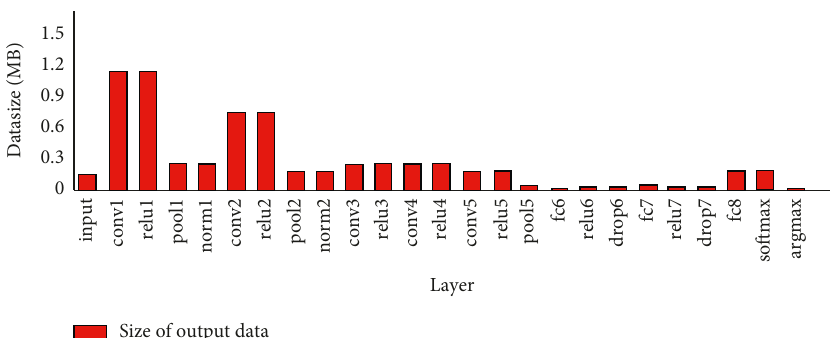
Figure 7: The size analysis of the data generated from the various layers of the AlexNet neural network.